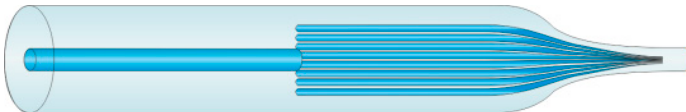
Figure 16. Schematic diagram of the SPST.